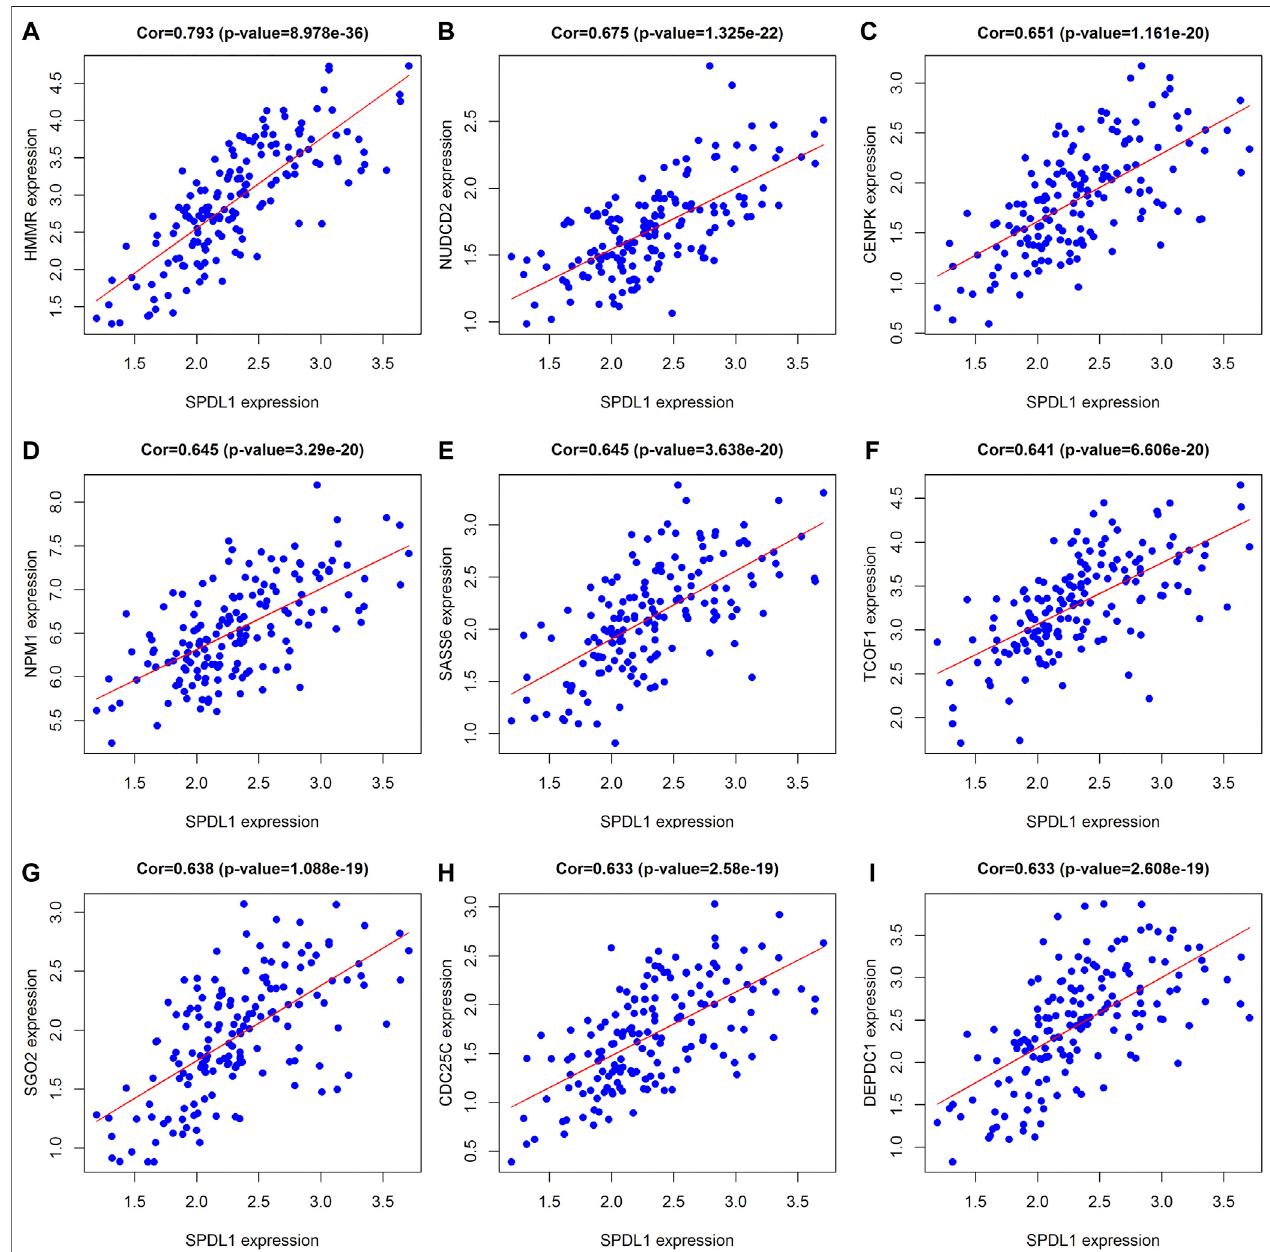
FIGURE 6 | Genes co-expressed with SPDL1 ranked are shown using correlation coef fi cient. (A) HMMR; (B) NUDCD2; (C) CENPK; (D) NPM1; (E) SASS6; (F) TCOF1; (G) SGO2; (H) CDC25C; and (I) DEPDC1. ESCA, esophageal cancer tissue; SPDL1, spindle apparatus coiled-coil protein 1.